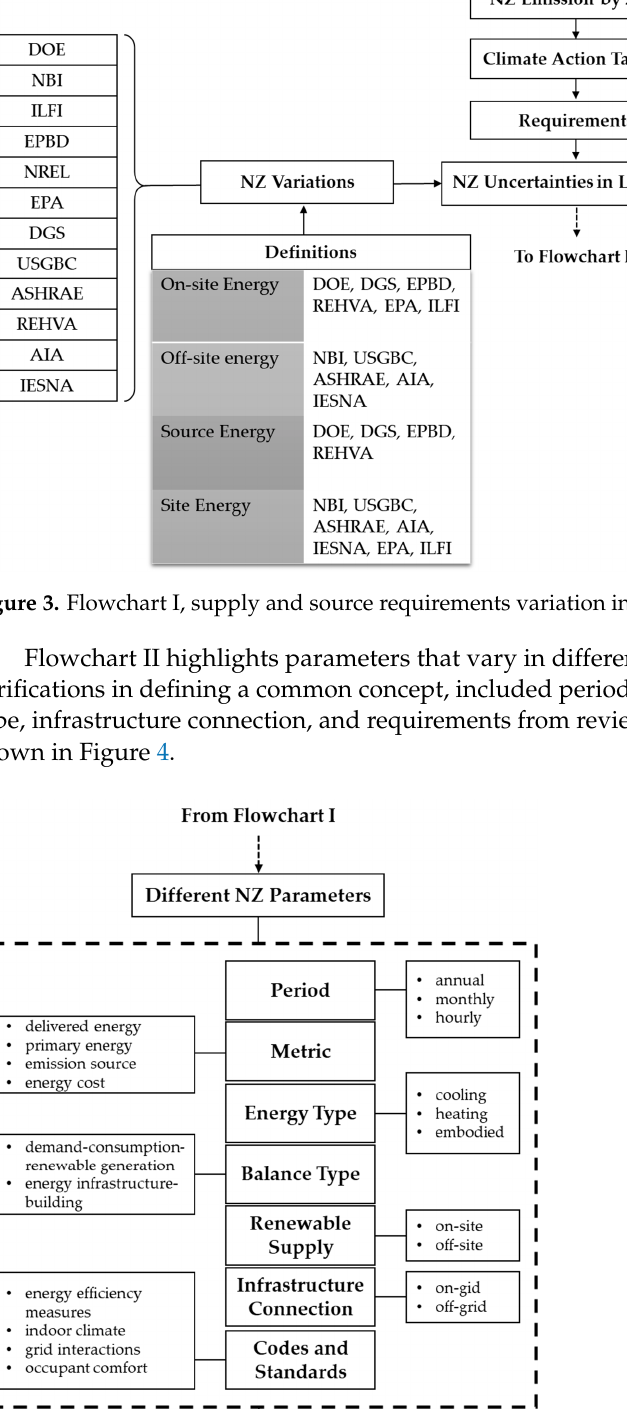
Figure 5. Flowchart III, hierarchical proposed Process for Clarification to Accelerate Net Zero (PC-A-NZ) through varia- tions, strategies, and requirements.